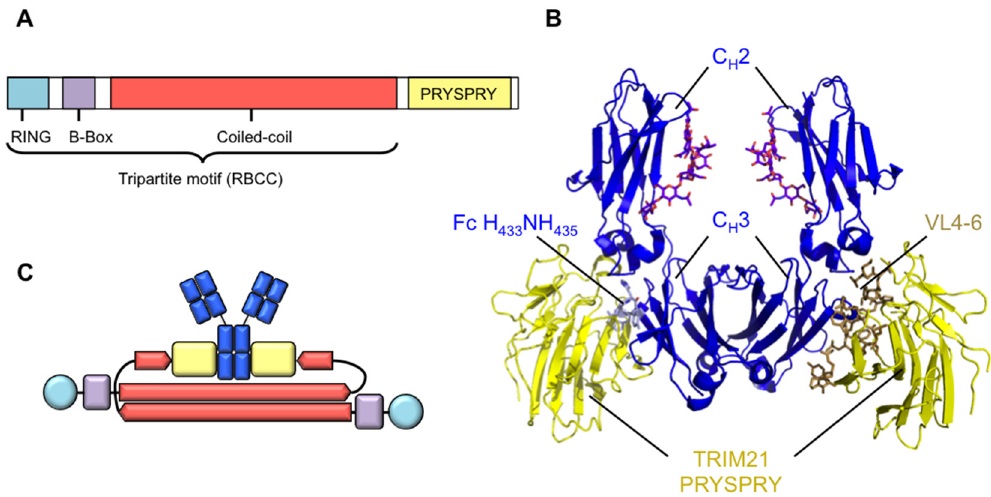
Figure 1. Molecular architecture of TRIM21. ( A ) TRIM21 contains a tripartite or RBCC motif, bearing an N ‐ terminal RING domain, a B ‐ Box and a coiled ‐ coil domain, which consists of heptad and hendecad repeats that form an extended helical structure. TRIM21 bears an additional C ‐ terminal PRYSPRY domain responsible for binding IgG Fc; ( B ) Crystal structure of IgG Fc ( blue ) complexed to TRIM21 PRYSPRY domain ( yellow ). The H433N434H435 motif in CH3 is accommodated in the PRYSPRY binding pocket created by variable loops (VL) 4, 5 and 6. PDB: 2IWG; ( C ) Predicted domain organisation of TRIM21 dimers. N ‐ terminal RING and B ‐ Box domains are held at opposing ends of the assembly due to anti ‐ parallel association of the coiled ‐ coil domains. PRYSPRY domains are predicted to be held centrally. Colour scheme as in (A).